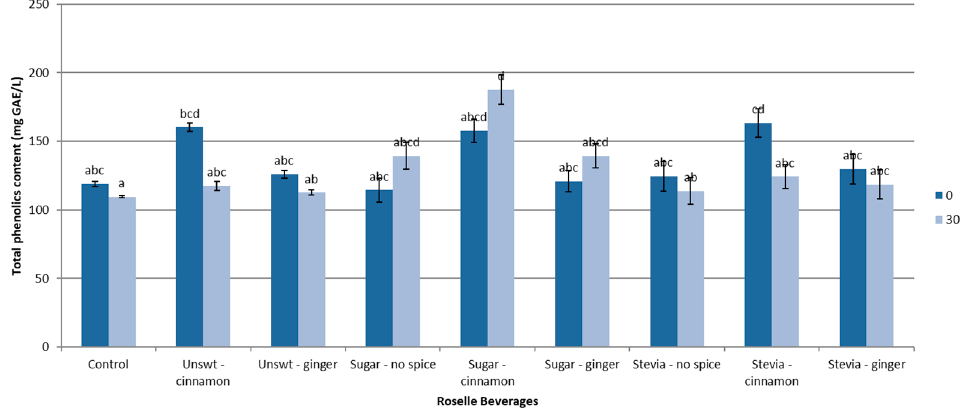
Figure 2. Total phenolic content (mg GAE/L) profile of the unsweetened or sweetened Roselle beverages (with sugar or Stevia Reb A) and with or without spice (cinnamon or ginger) on days 0 and 30 of the accelerated storage at 40 °C. Each bar/point represents mean values ± SD. Symbols a–d denote the level of differences between treatments.